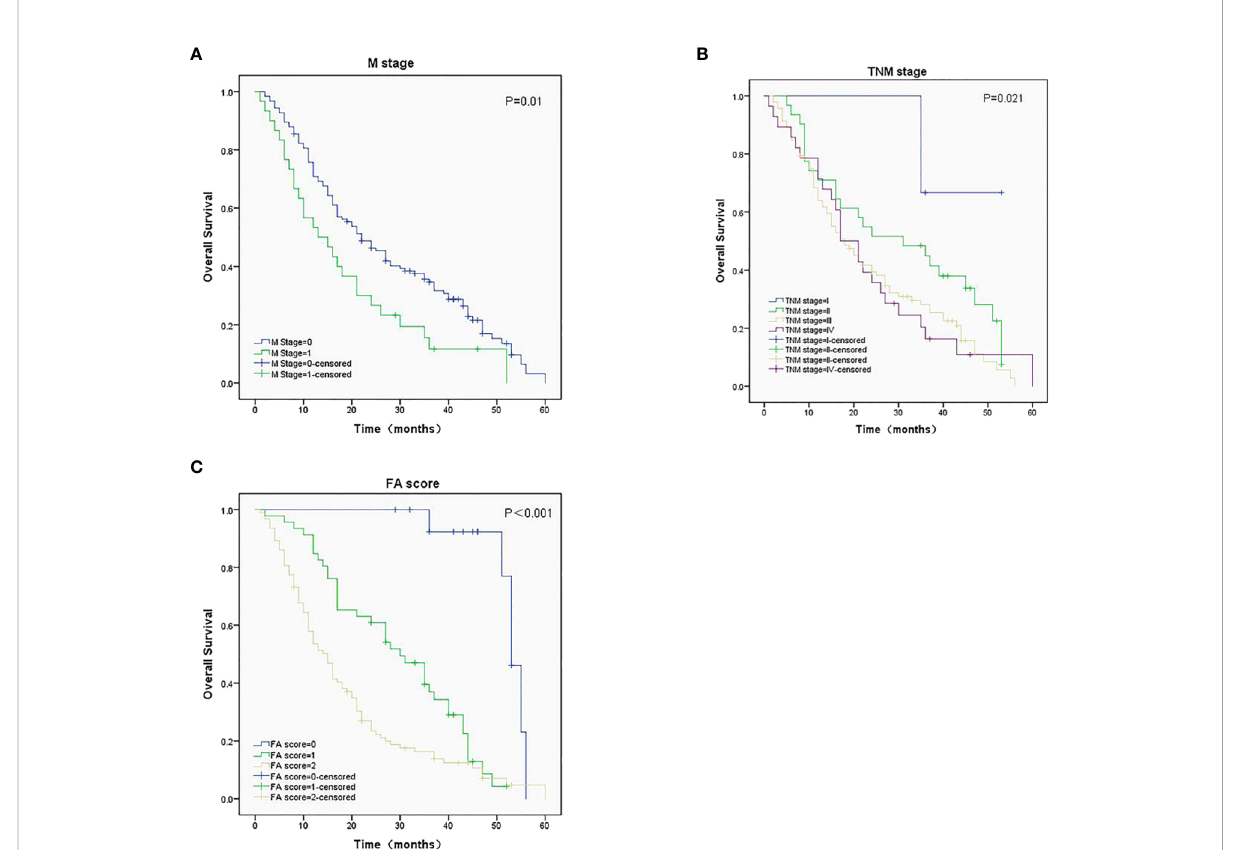
FIGURE 2 Survival analysis in ESCC patients with different M stage (A) , TNM stage (B) , and FA score (C) , P -values were 0.01, 0.021 and < 0.001,